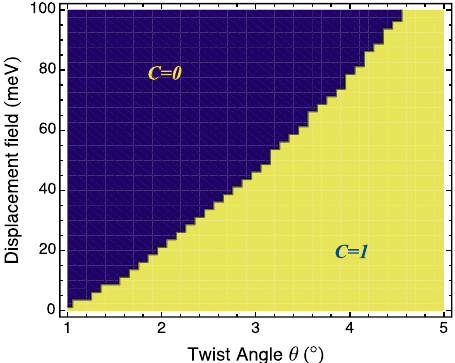
Fig. 5 Band topology. The plot shows the Chern number of the topmost moiré band as a function of twist angle and displacement fi eld. The relevant regime in our considerations has nontrivial Chern